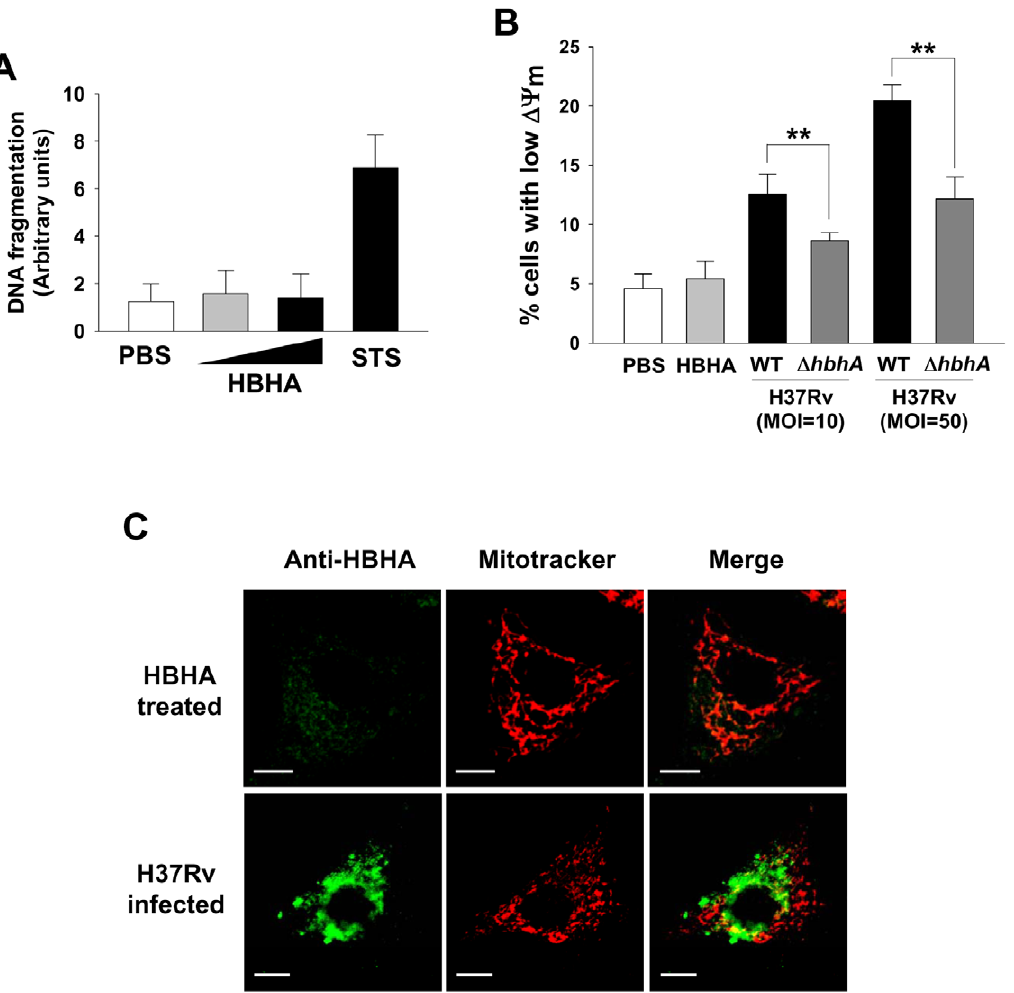
Figure 8. HBHA does not affect the viability of A549 cells. ( A ) DNA fragmentation of A549 cells incubated with HBHA (5 or 25 m g/mL) or PBS for 48 h was measured by Cell Death Detection ELISA. Staurosporine (STS, 1 m M, 4 h) was used as a positive control for apoptosis. Results are the mean 6 SD of three independent experiments. ( B ) A549 cells were incubated with 25 m g/mL of HBHA or infected with M. tuberculosis wild-type (WT) and mutant ( D hbhA ) at an MOI of 10 or 50 for 24 h. Cells were stained with DiOC 6 . As described in Figure 2, the loss of DY m was evaluated by flow cytometry. All values are the mean 6 SD of three separate sets of experiments. ** P , 0.01 between cells infected with WT and mutant strains. ( C ) Representative confocal images of HBHA (green) and Mitotracker (red) in A549 cells treated with HBHA (10 m g/mL) (upper) or M. tuberculosis at an MOI of 10 (lower). Scale bar, 10 m m.